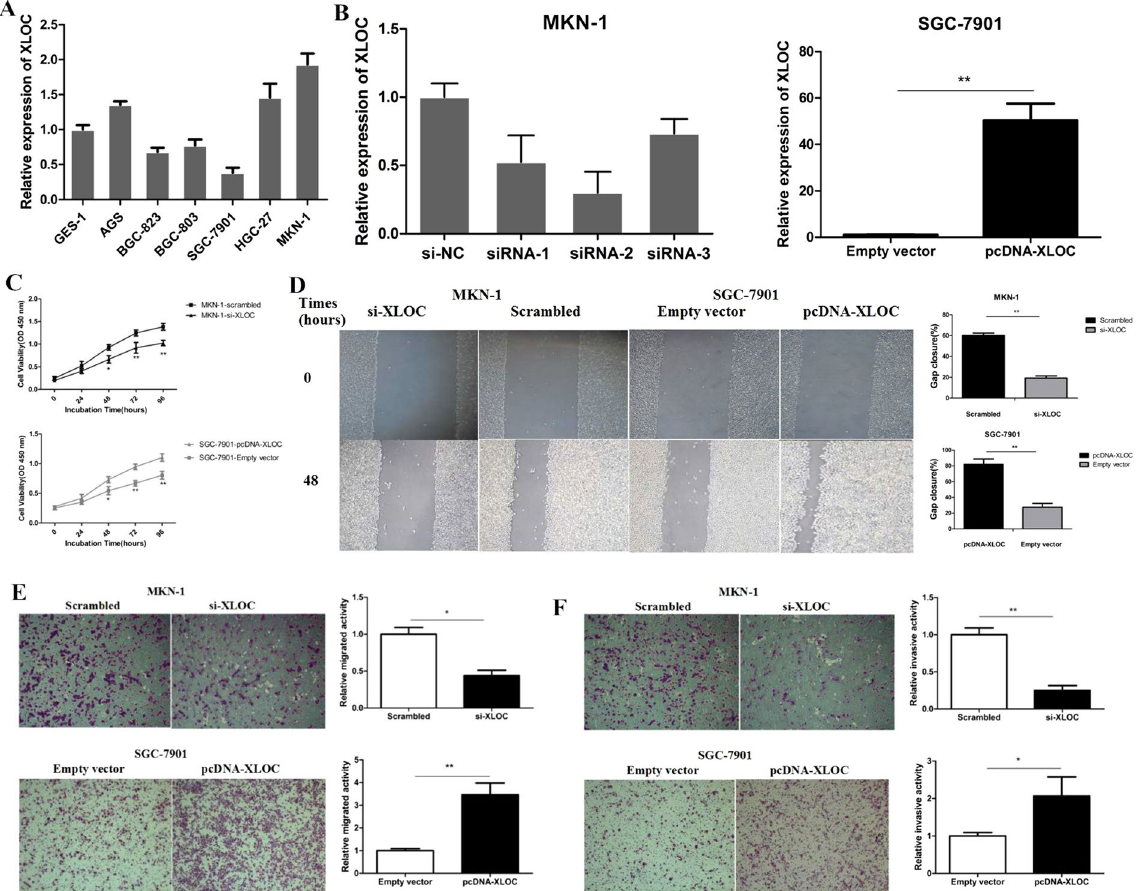
Figure 1. Effects of XLOC_010235 on gastric cancer cell migration and invasion in vitro . SGC-7901 cells were transfected with pcDNA-XLOC_010235, and MKN-1 cells were transfected with si-XLOC_010235. ( A ) XLOC_010235 expression levels of GC cell lines (AGS, BGC-823, BGC-803, SGC-7901, HGC-27, MKN-1) compared with that in normal human gastric epithelial cells (GES-1). ( B ) q-PCR analysis of XLOC_010235 expression levels following the treatment of MKN-1 cells with scrambled siRNA and si-XLOC_010235 (left panel), and the treatment of SGC-7901 cells with empty vector and pcDNA-XLOC_010235 (right panel). ( C ) Forty-eight hours after transfection, CCK-8 proliferation assays were conducted to determine the proliferation of MKN-1 and SGC-7901 cells. ( D ) Wound healing assays were performed to investigate the migratory ability of gastric cancer cells. ( E , F ) Transwell assays were used to investigate the changes in the migratory and invasive abilities of gastric cancer cells. All experiments were performed in triplicate. Bars: SD. Bars: SD; * p < 0.05 and ** p <